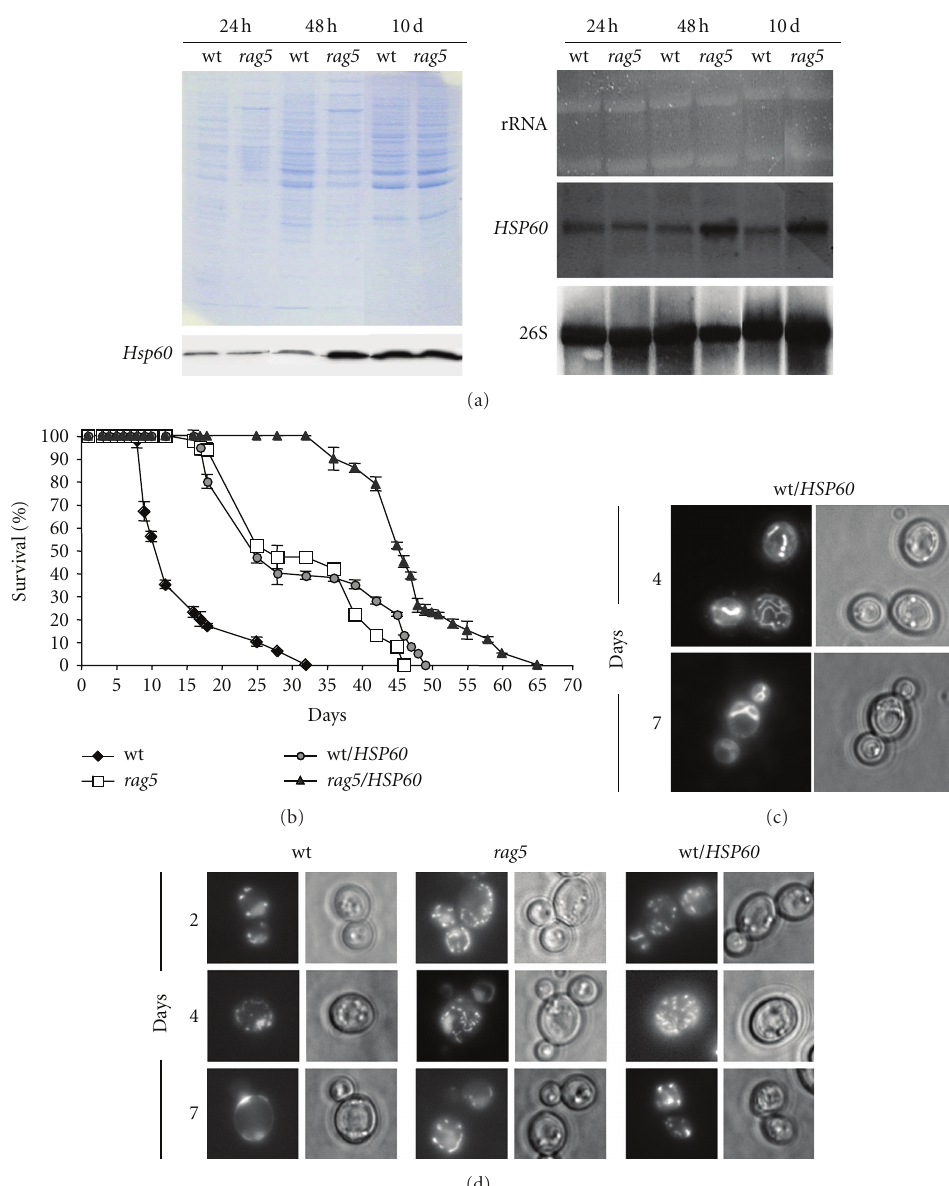
Figure 5: Analysis of involvement of Hsp60 in chronological aging and mitochondrial functionality. (a) Analysis by SDS-PAGE, western blotting of Hsp60 protein and northern analysis of HSP60 in the wt and in the isogenic rag5 Δ strain. Determination of protein level by western analysis was performed as described in Section 2. Total mRNAs were prepared as described in Section 2 from cells grown on YPD medium for 24, 48hr, 10 days. RNA was hybridized with labelled probes for HSP60 and 26S. Data are representative of three independent experiments, repeated with similar results. (b) Evaluation of gene dosage of HSP60 in determining the lifespan. Comparison of chronological survival in YPD medium of wt, rag5 Δ strain, and the same strains overexpressing HSP60 gene. Survival was assessed in minimal medium for plasmid maintenance. Over time, aliquots of cultures were counted and serial dilutions were plated on solid medium. Colony forming units were counted after 3 days. Data are representative of three independent experiments, mean ± s.d. (c) DASPMI staining in wt cells overexpressing HSP60 gene after growth in YPD medium. Analysis was performed by taking aliquots at the indicated times and observing cells after DASPMI staining at the fluorescence microscopy. (d) Evaluation of mitochondrial nucleoids morphology along CLS in rag5 Δ , wt and wt/HSP60 strains. Samples were collected at the indicated time-points and fluorescence was observed after DAPI in vivo